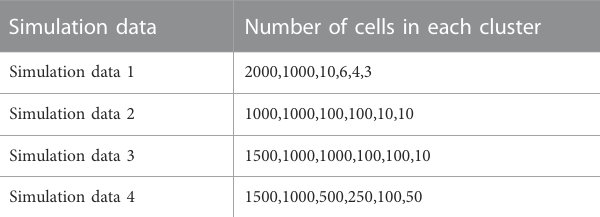
TABLE 1 The number of each type of cells in each simulation